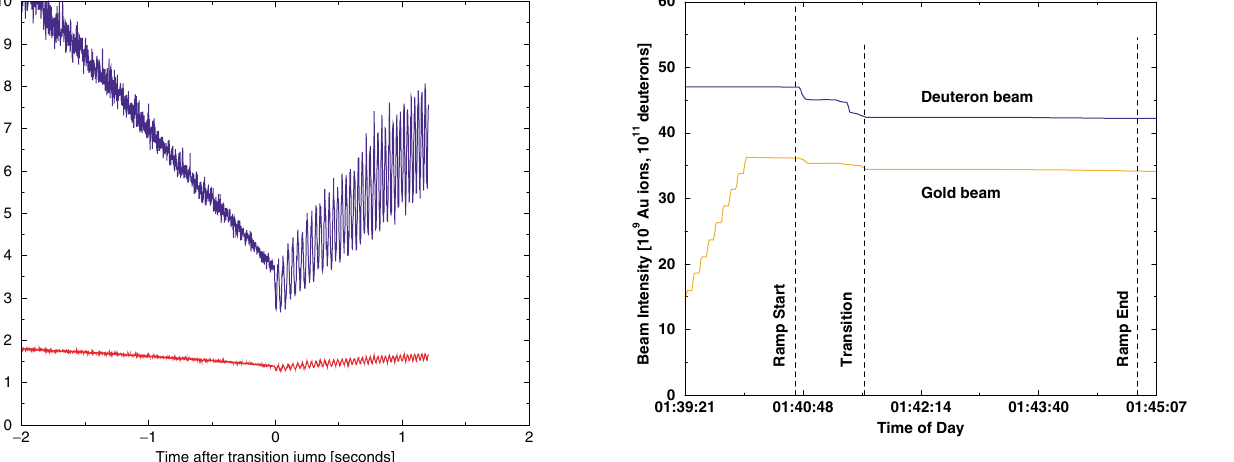
(red line) and s (blue curve) after adjusting the x quadrupole t